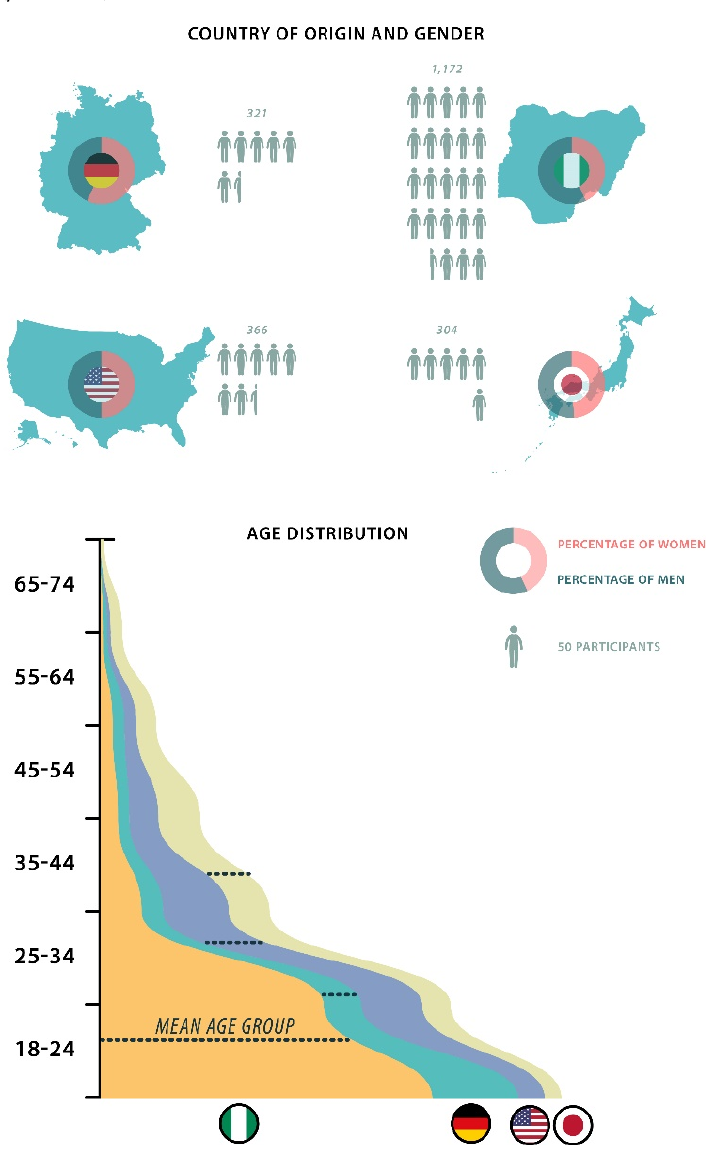
Figure 1. Demographic data of the complete survey population. The number of participants, their relative gender distribution and the mean age groups are shown.